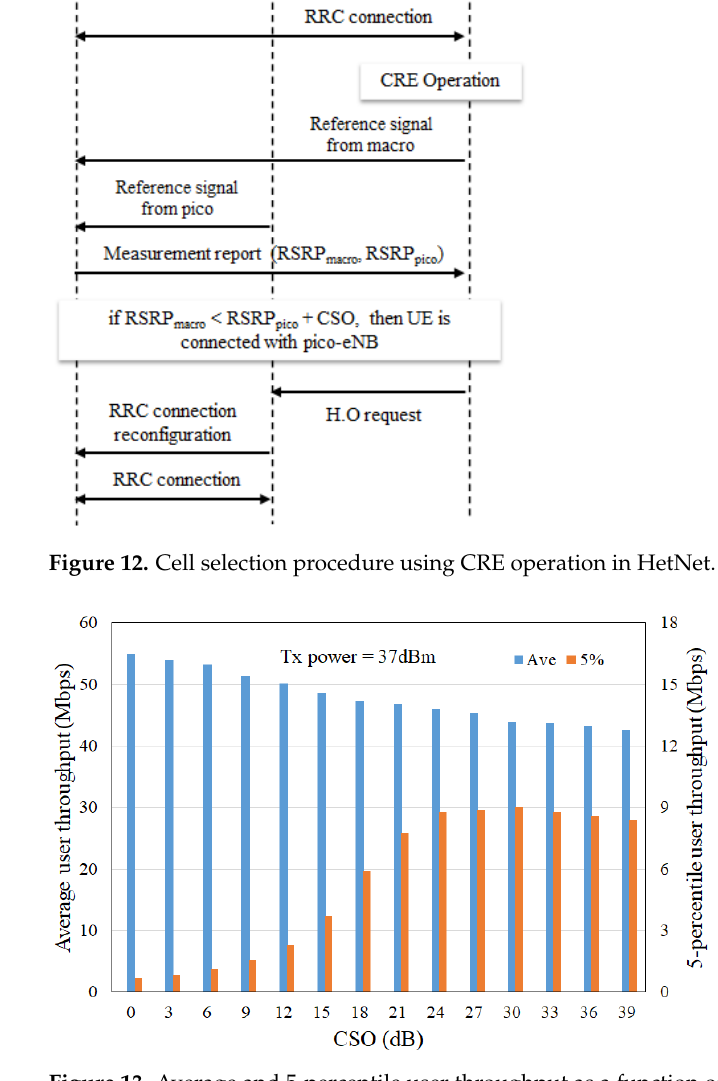
Figure 13. Average and 5-percentile user throughput as a function of CSO for pico-eNB Tx power of 37 dBm.